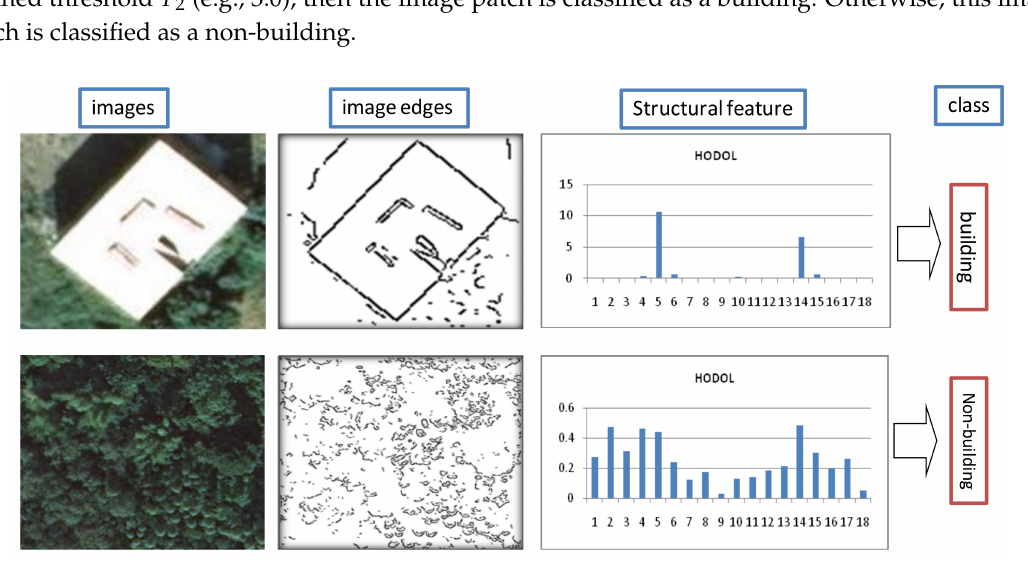
Figure 5. Structural feature for classifying buildings and non-buildings.